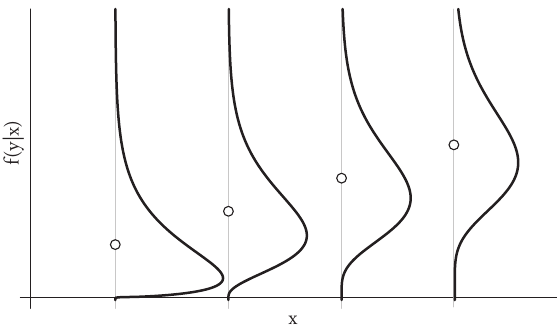
Figure 1: Gamma distributed conditional